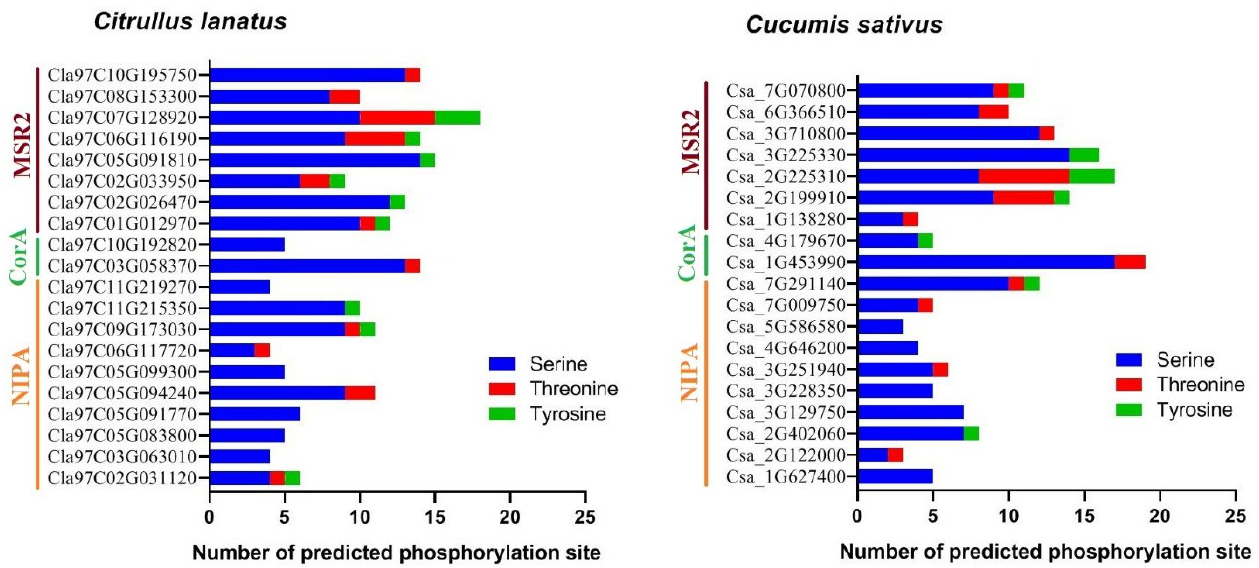
Figure 6. Prediction of phosphorylation site of MGT proteins in C. lanatus and C. sativus .